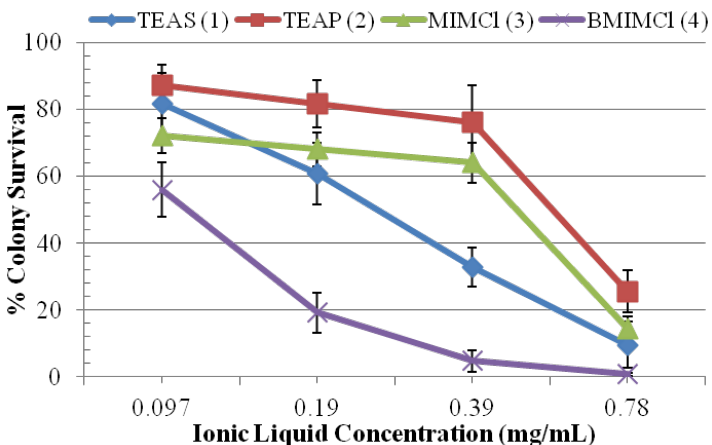
Figure 6. Effect of ILs on the colony-forming capacity or clonogenic survival of exponentially growing T98G cell lines studied by a clonogenic assay. Data presented are mean values from three independent observations, n = 3. All values are considered significant, when p <